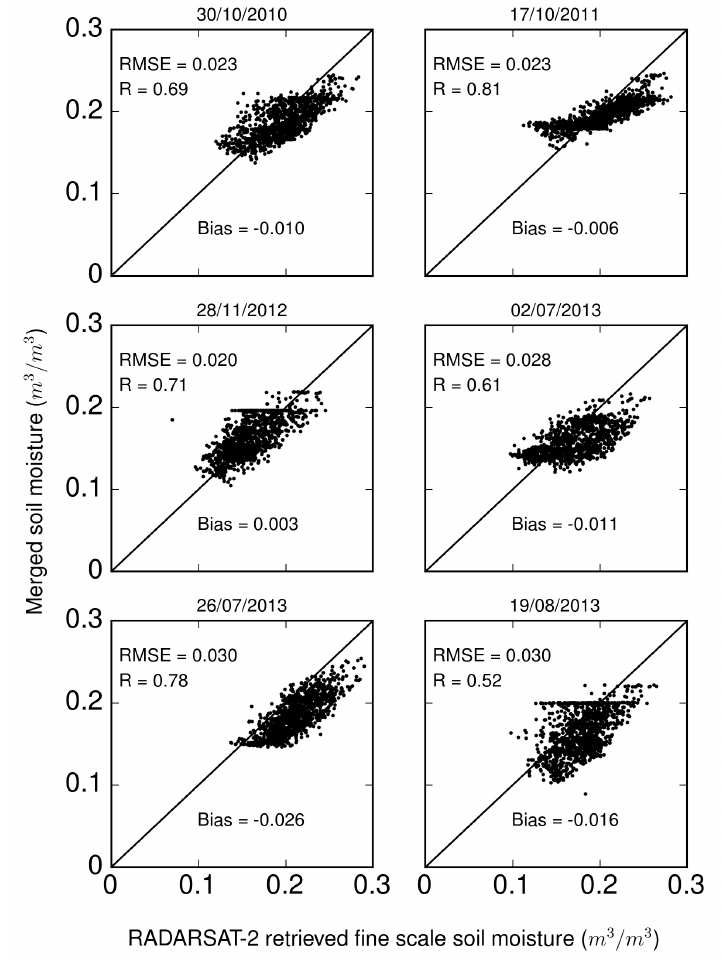
Figure 18. Comparison of the merged soil moisture with the RADARSAT-2 retrieved soil moisture at a spatial resolution of 500 m for the C-Cal experiment.